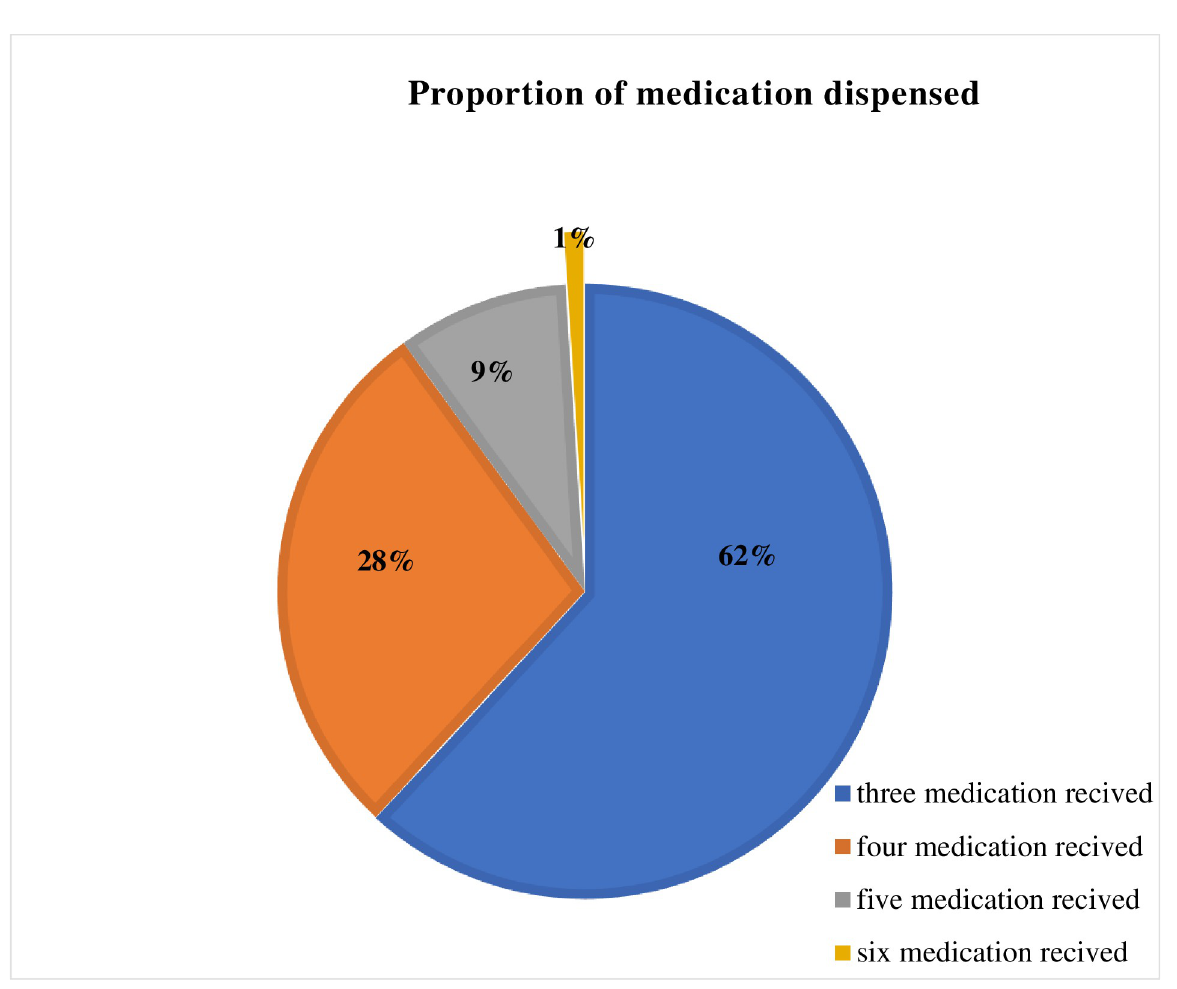
PLOS ONE | https://doi.org/10.1371/journal.pone.0280204 January 12,